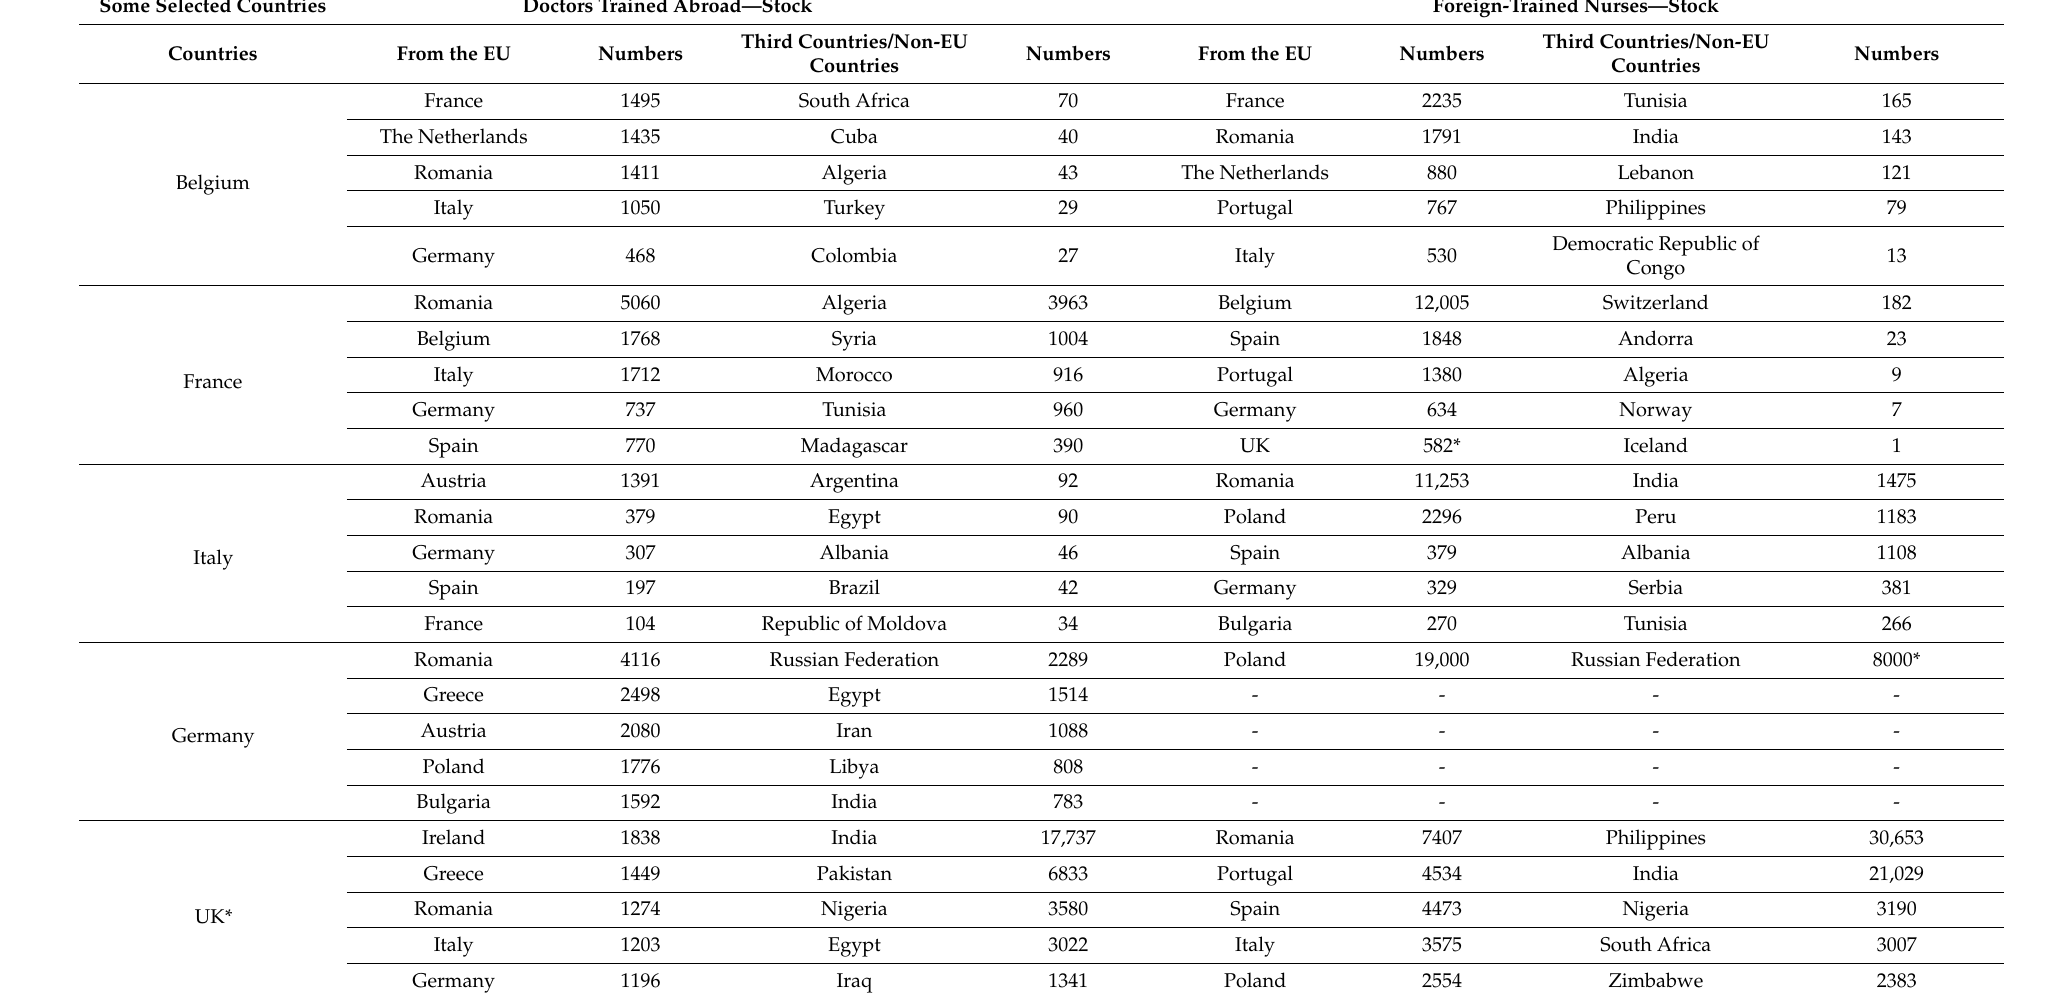
Table 2. Foreign-trained doctors and nurses by country of origin in 2019 */2020—Stock. Some Selected